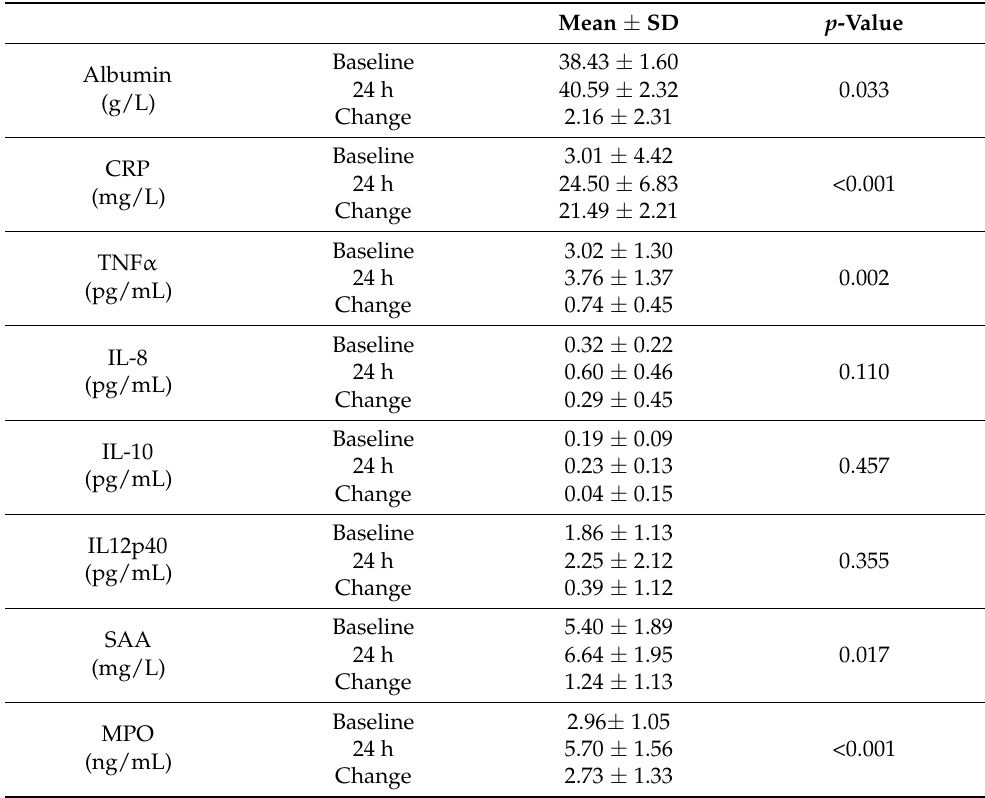
Table 1. Plasma concentrations of inflammatory markers before and after 24 h following LPS infusion in all participants ( n =